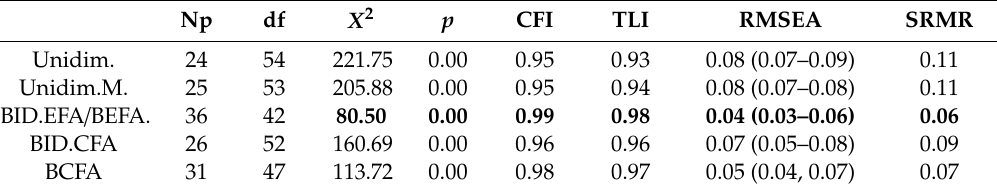
Table 2. Model fit indices for all tested